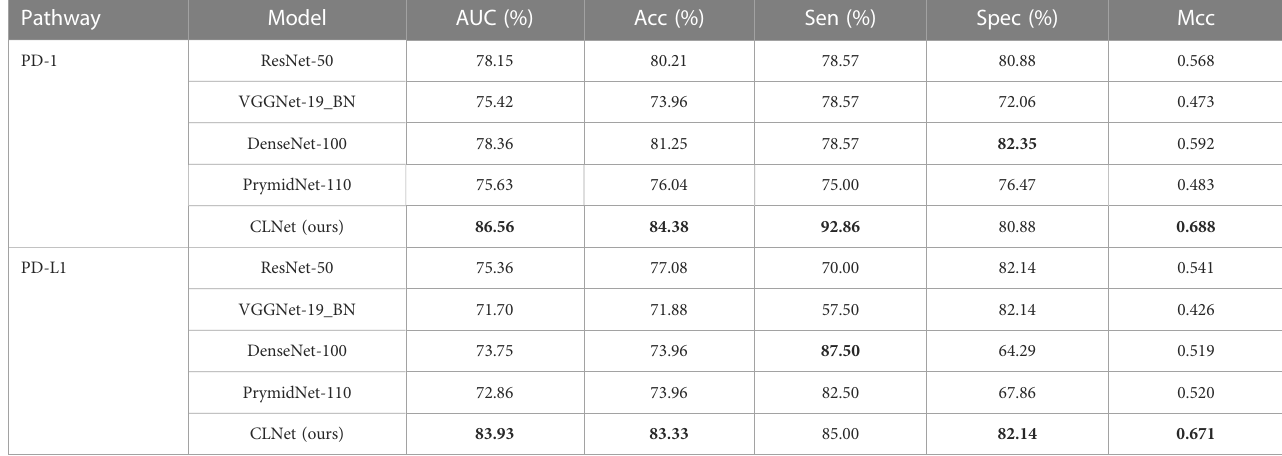
TABLE 2 Performance comparison between proposed CLNet with other DL models such as ResNet-50, VGGNet-19 BN, DenseNet-100, and PrymidNet- 110 for predicting PD-1 and PD-L1 expressions. Pathway